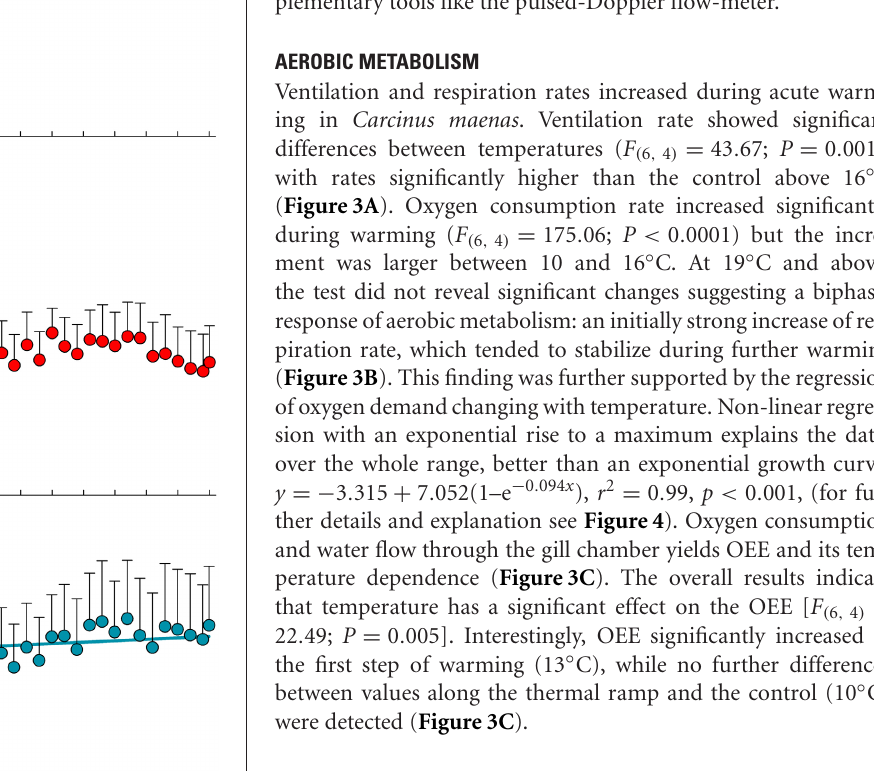
each contraction multiplied by heart rate ( Figure 2C ). There was no significant change in cardiac output between 10 and 25 ◦ C, indicating that the stroke volume decreased with rising